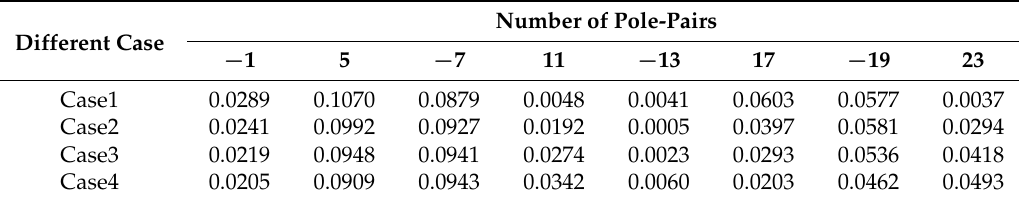
Table 7. The amplitude of the radial magnetic field by the armature reaction on rated load alone in the air gap (unit: